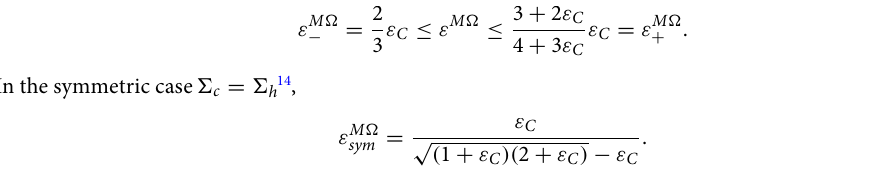
τ/( 1 τ) is the COP of the Carnot cycle and τ where ε C = − the limits (cid:31)